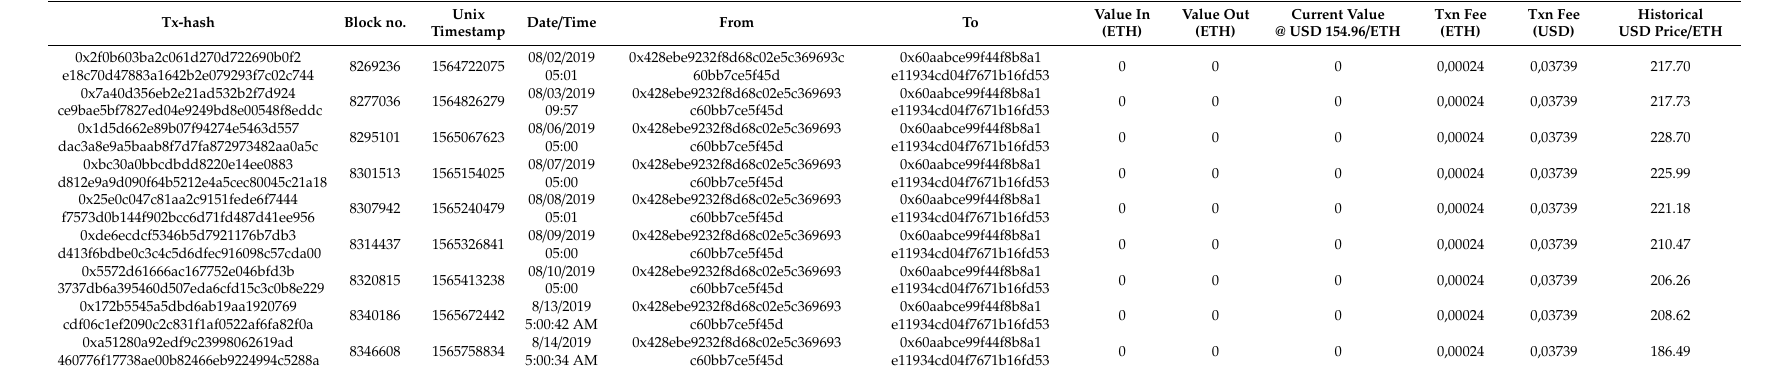
Table 1. Data written in the sender wallet.